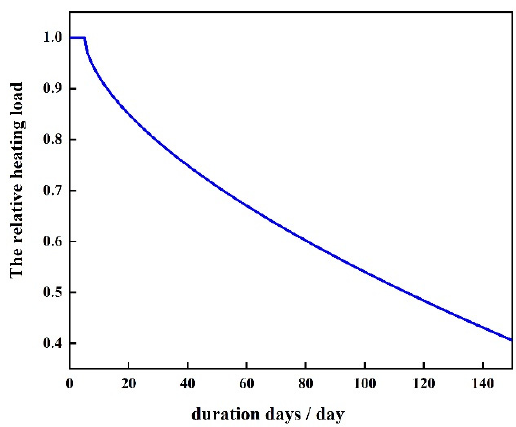
Figure 2. A typical characteristic curve of heating load.